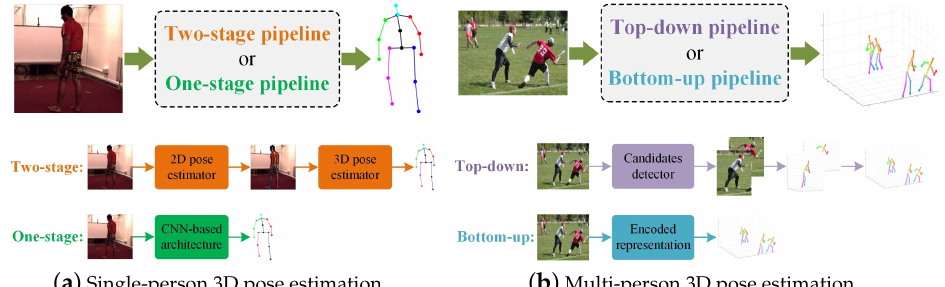
Figure 3. The standard methodologies of single-person and multi-person 3D pose estimation. The input 2D image and the predicted 3D human pose in ( a ) come from the samples and GT in the Human3.6M Dataset [36], respectively. The input 2D image and the predicted 3D human pose in ( b ) are quoted from Reference